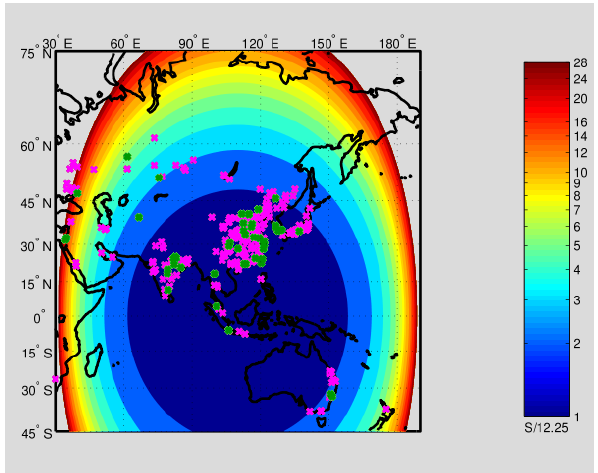
Fig. 16. Locations of power plants emitting in the range 5– 15MtCO 2 yr − 1 (magenta) and greater than 15MtCO 2 yr − 1 (green). The background colour shows the ratio of the geoCARB pixel area to the subsatellite pixel area (12.25km 2 ).